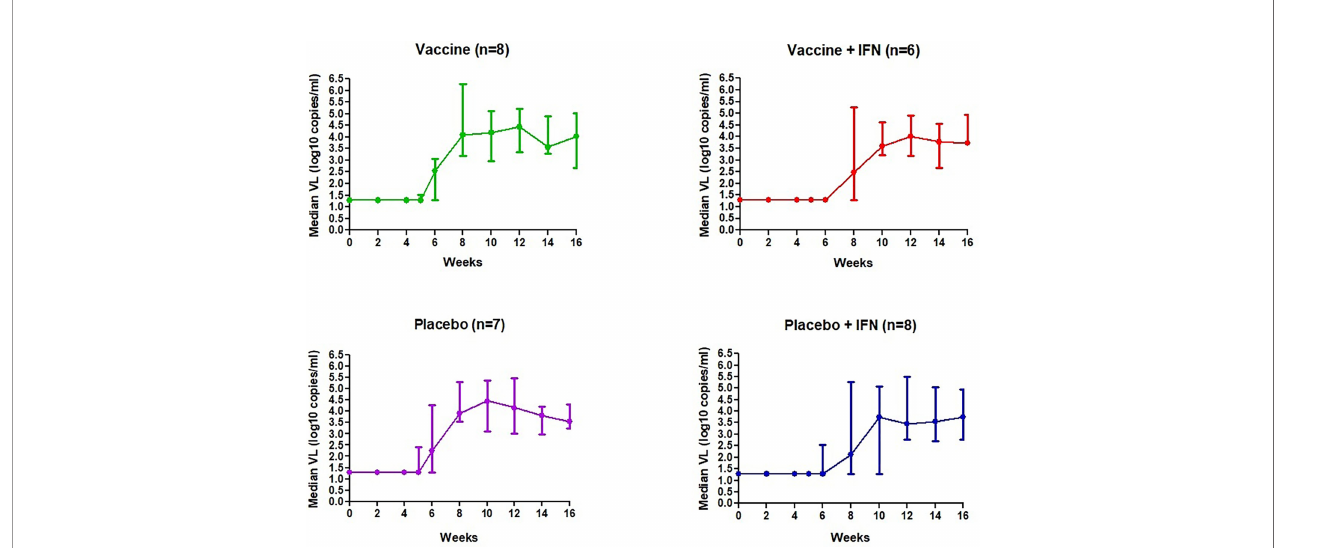
FIGURE 3 | Median VL (log 10 copies/ml) during vaccination and ATI per study group.